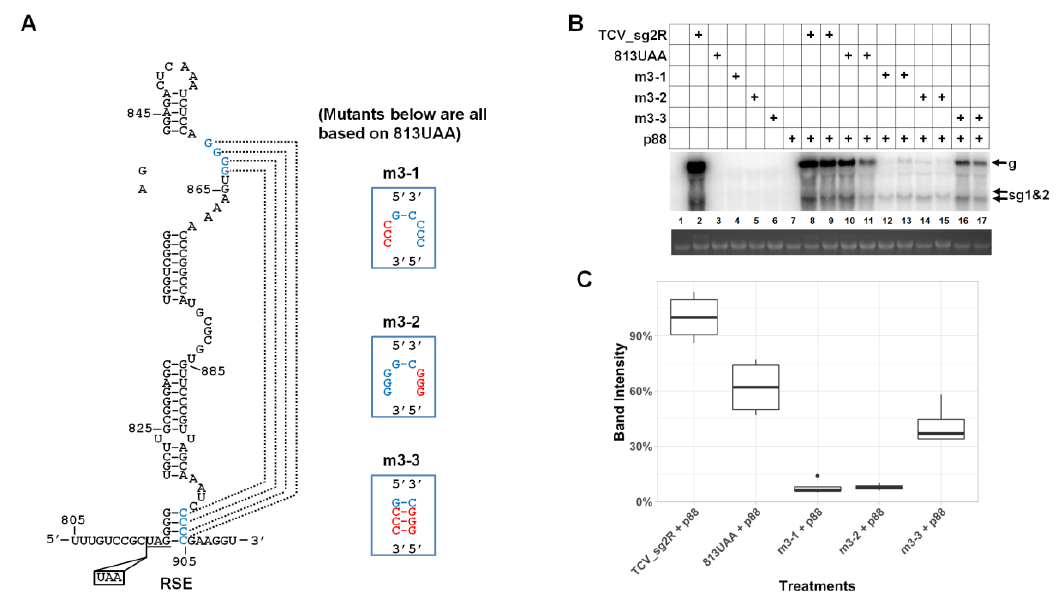
Figure 3. The intra-RSE pseudoknot has a read-through-independent role in TCV gRNA accumulation. ( A ) The intra-RSE pseudoknot. The nts implicated in the pseudoknot are highlighted in blue letters, with the anticipated base-pairing relationship denoted with dotted lines. Three mutants tested, with m3-1 and m3-2 disrupting the pseudoknot, and m3-3 restoring the pseudoknot by combining the mutations in m3-1 and m3-2, are also depicted. ( B ) A representative Northern blotting showing accumulation levels of the pseudoknot mutants. ( C ) Box plot quantification of Northern blotting results from multiple repeats.